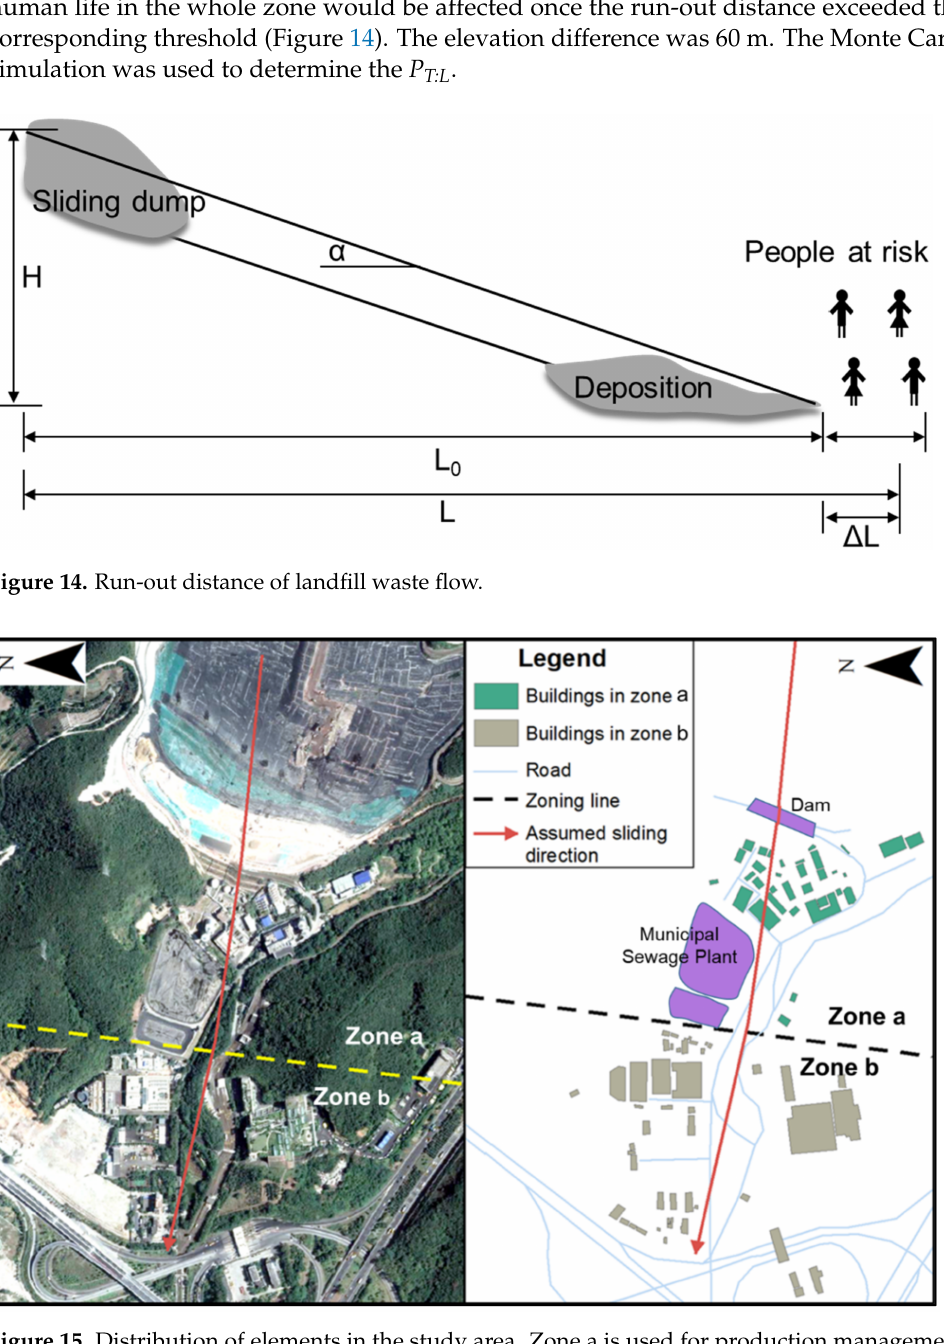
Figure 15. Distribution of elements in the study area. Zone a is used for production management, while Zone b is used for office and living